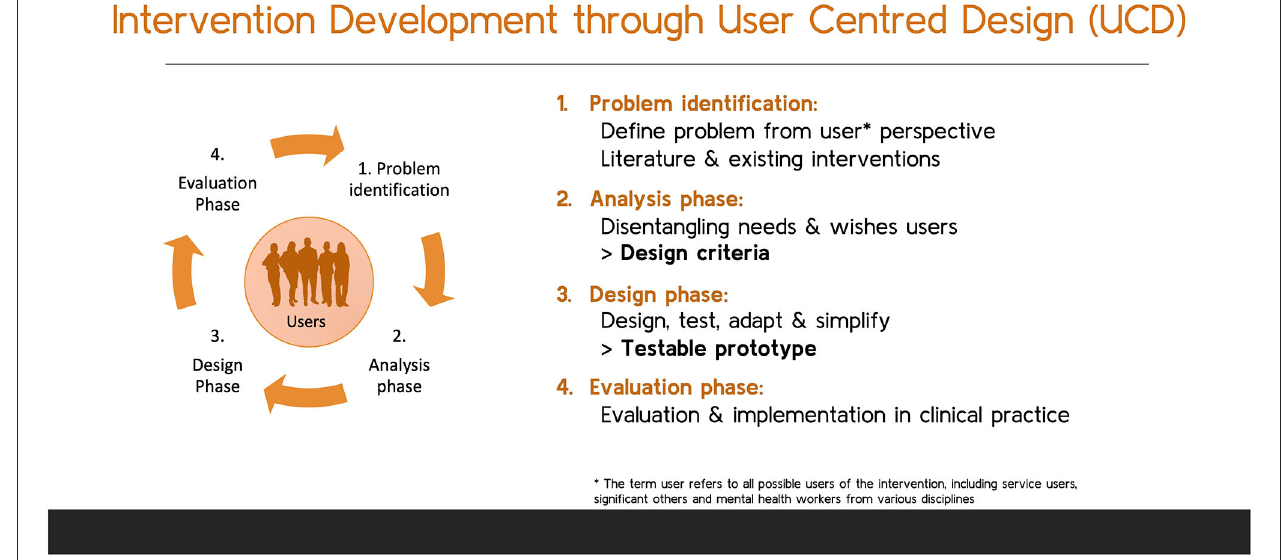
FIGURE 1 | Visual